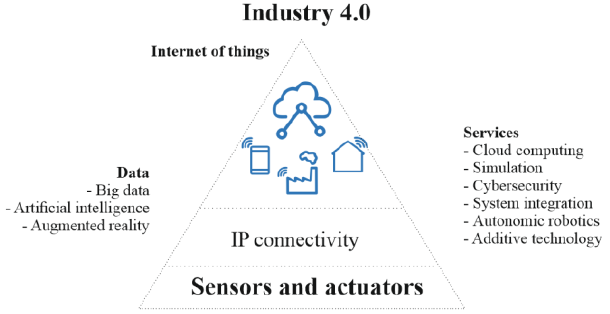
Fig. 1. Industrial transformation